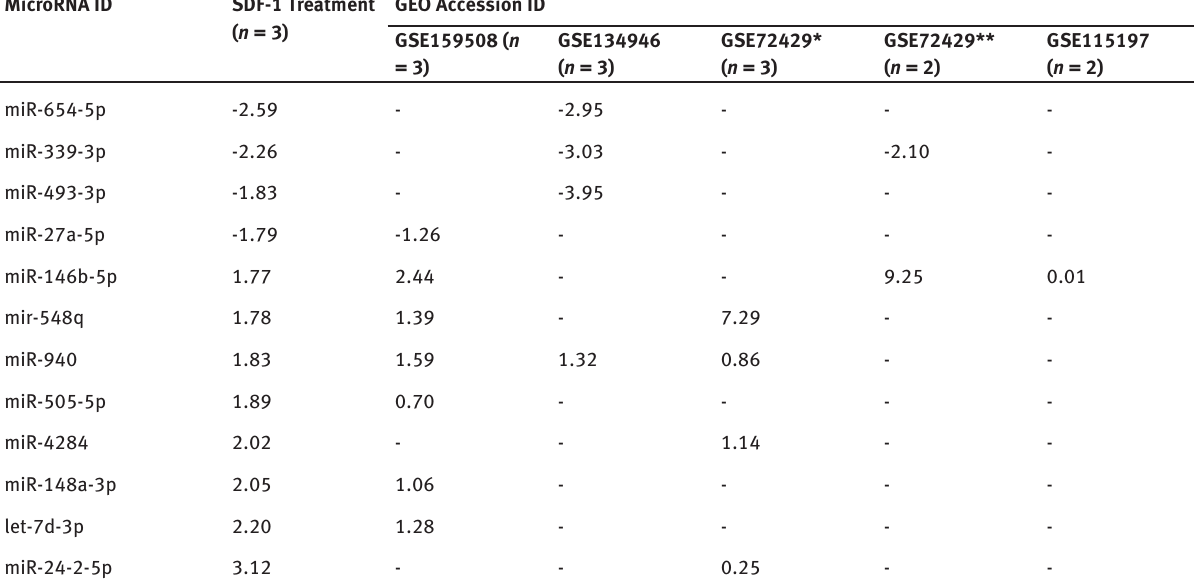
Table 5: List of common miRNAs differently expressed after SDF-1 treatment and after various osteogenic differentiation protocols (retrieved via GEO database analysis). GSE159508 presents human periodontal ligament stem cells (hPDLSCs) cultured in osteogenic medium for 14 days compared to hPDLSCs cultured in normal medium (10% FBS in DMEM) for 14 days. GSE134946 and GSE115197 presents human BMSCs cultured in osteogenic medium for 7 days compared to non-induced BMSCs from day 0. GSE72429 presents human synovial membrane MSCs and adipose derived stem cells (ADSCs) osteogenically differentiated compared to undifferentiated controls. Differential expression is reported as miRNA fold change after treatment compared to respective control. All reported fold changes are statistically significant based upon GEO2R adjusted p